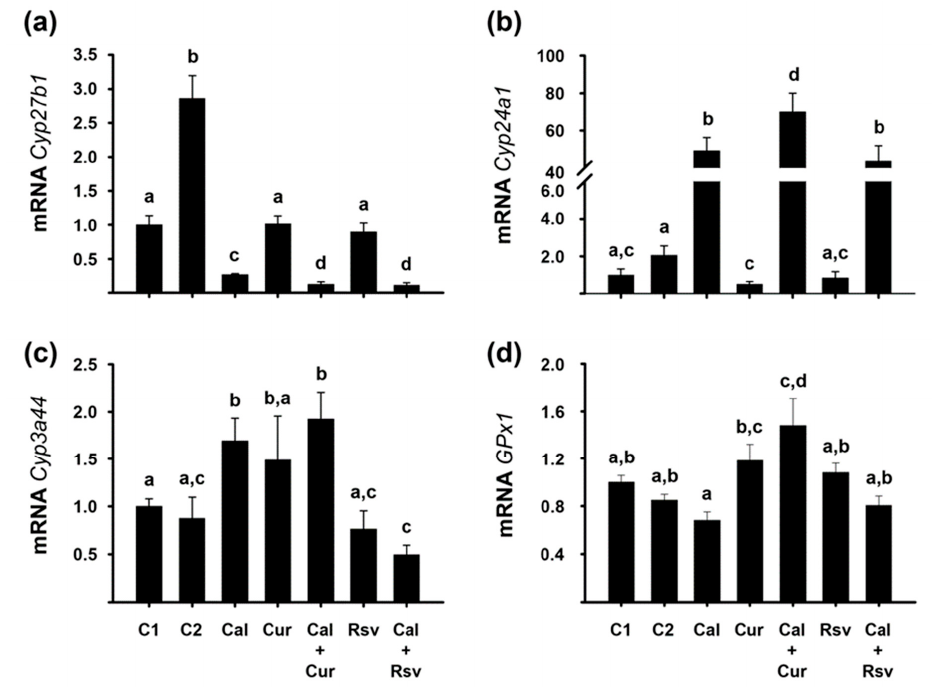
Figure 7. Curcumin and resveratrol enhanced the bioactivity of calcitriol, as deduced by the gene expression profile of vitamin D-metabolic cytochromes in the kidney of treated mice, while the phytochemicals biological effect was reflected in the liver biomarkers GPx1 and Cyp3a44 . ( a , b ) Renal mRNA expression of Cyp27b1 and Cyp24a1 . ( c , d ) Hepatic mRNA expression of Cyp3a44 and GPx1 . Mice were treated for three weeks with saline solution (C1), vehicle (C2), calcitriol (Cal), curcumin (Cur), resveratrol (Rsv), or the co-treatment of calcitriol with Cur or Rsv (Cal+Cur or Cal+Rsv, respectively). The RT-qPCR results were normalized against the gene expression of Actb and vs. C1 values, which were set to 1. Mean ± SEM. Bars not sharing a letter differ significantly ( p < 0.05). N ≥ 9.